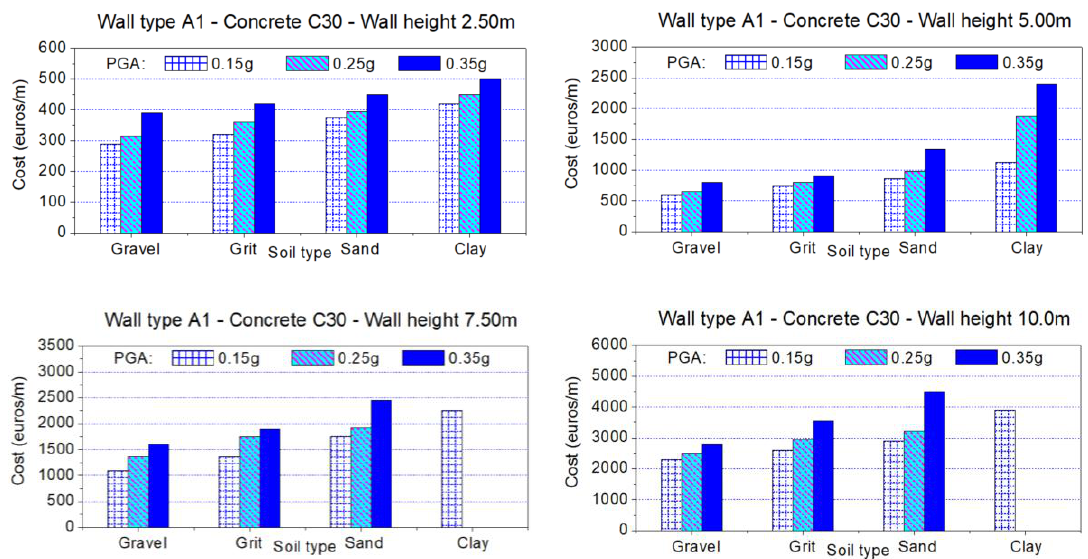
Figure 5. Cost of retaining walls type A1 made by reinforced concrete C30.